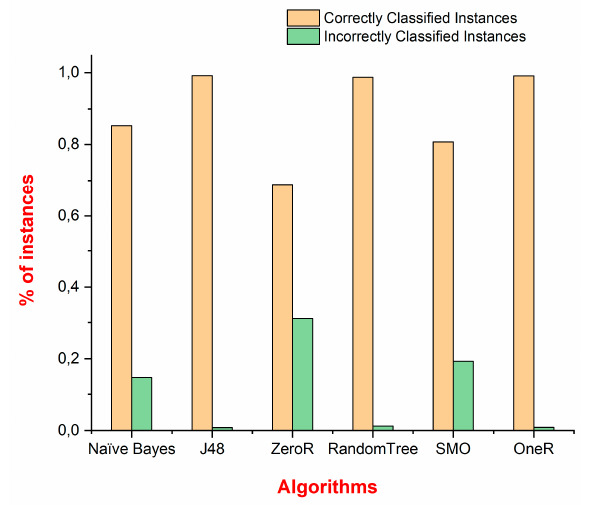
Figure 10. The graph of correctly and incorrectly classified instances of algorithms.